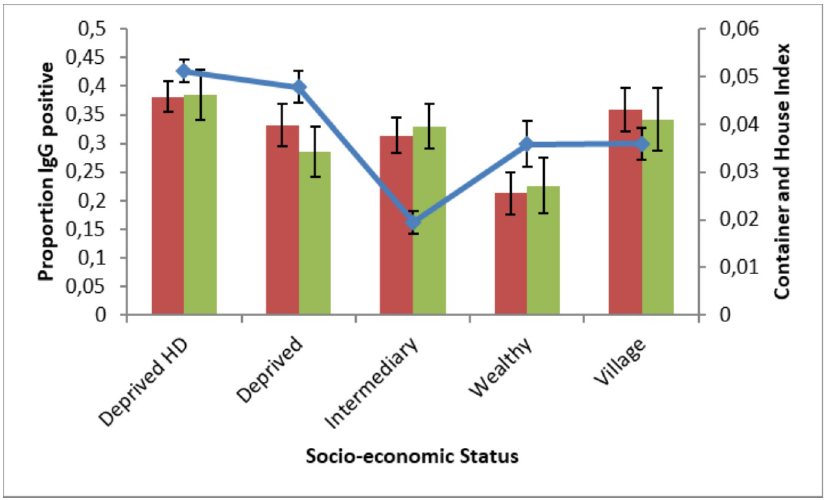
Fig 2. Container (green bars) and House (red bars) Indices (proportion of containers positive per house and houses positive for mosquito larvae respectively) (means and standard errors) and IgG prevalence rates (blue line, means and binomial errors) by SES